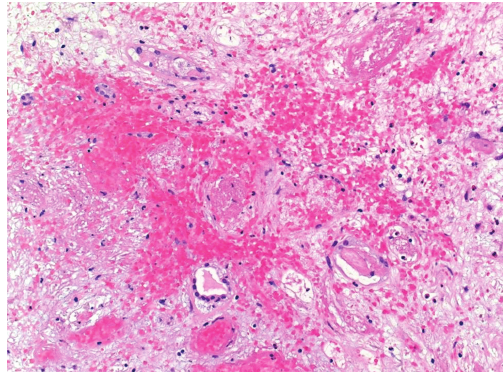
Figure 3: Marked interstitial oedema and haemorrhage (H&E ×